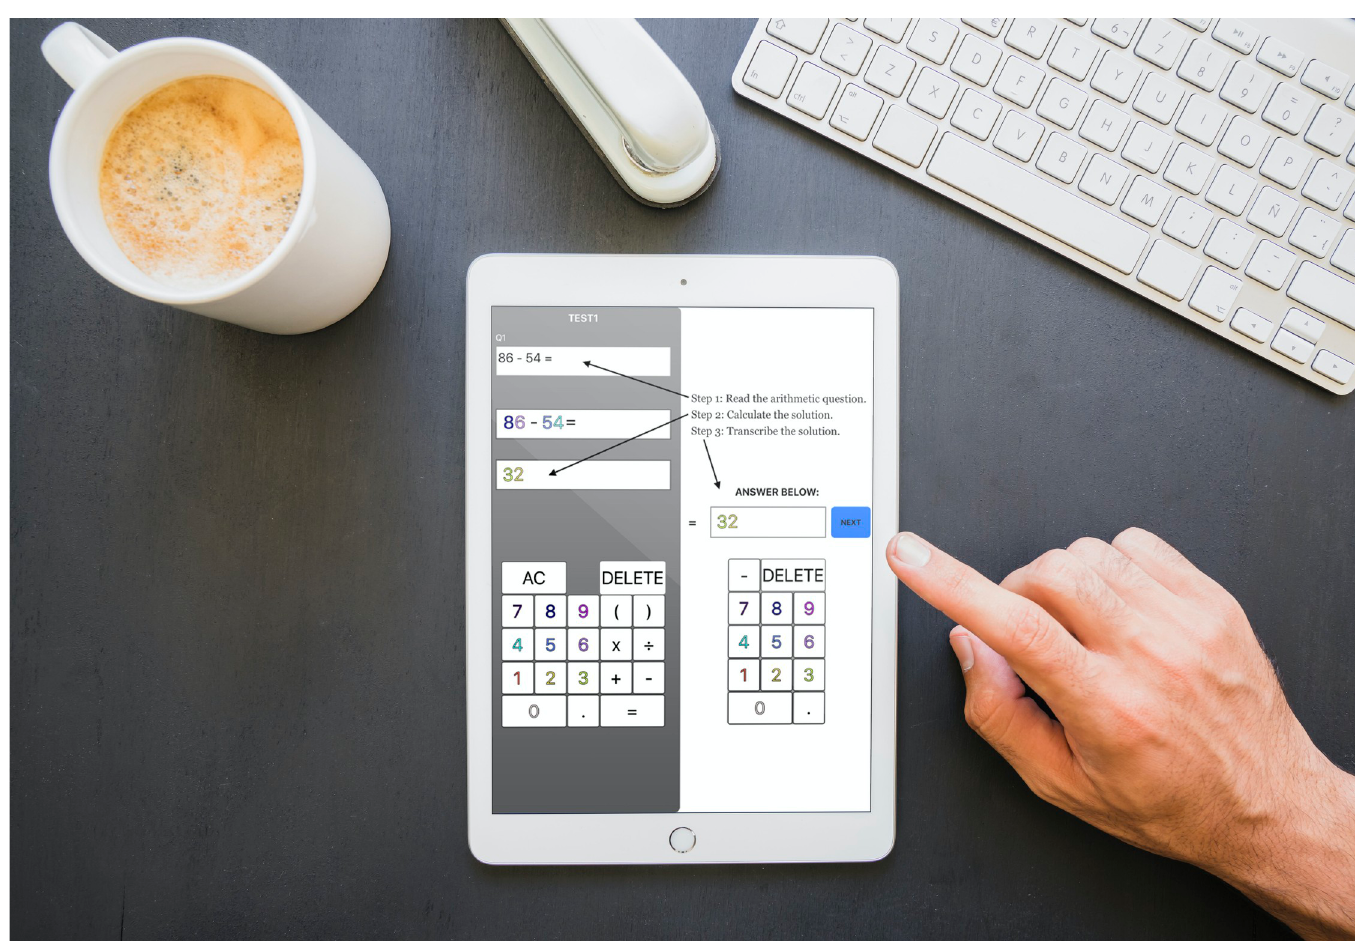
Fig 1. A user interacts with the task interface as displayed on a tablet device. The annotations indicate the three steps needed to complete each item which were (1) Reading: read an achromatically presented arithmetic problem that appeared in the upper left box; (2) Working: use the calculator number pad that is located at the lower left to solve the arithmetic problem; and (3) Transcribing; copy the solution across to the right via a congruously displayed answer pad, before pressing ‘next’. The dependant time variable used in our analysis that was measured for each item was the response time for each item; it was measured from presentation of the item until the participant pressed ‘next’. Note: this figure has been designed using content from Freepik.com and the annotations are for illustrative purposes only.